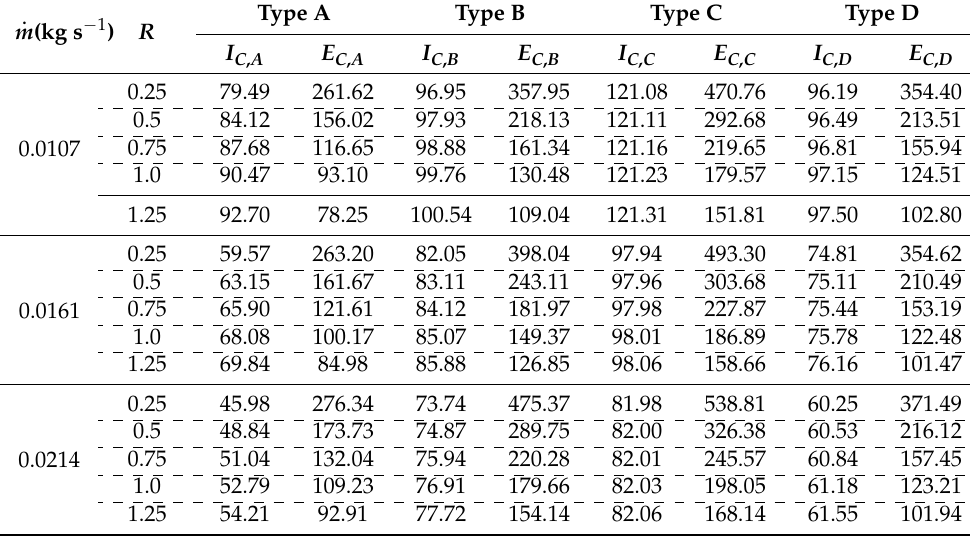
Table 6. Theoretical predictions of collector efficiency improvements and further collector efficiency enhancements with I 0 = 830 W/m 2 .